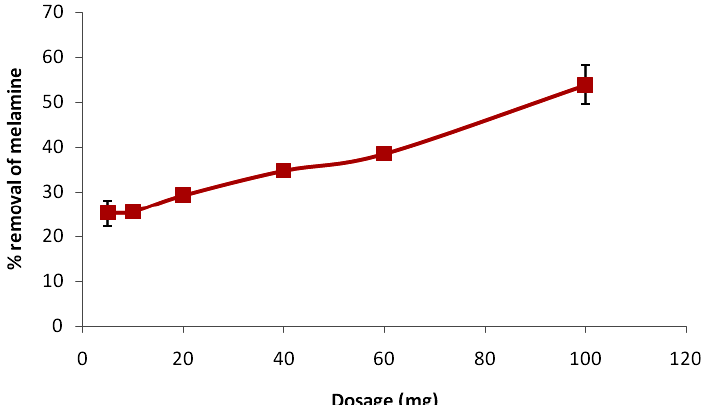
Figure 6. Removal of melamine at different dosage of Mel-MIP-9VC, the concentration of melamine solution is 10.0 ppm.